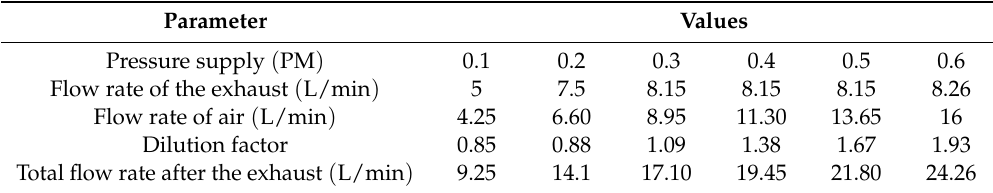
Table 3. Calculation of the flow rate and dilution factor.